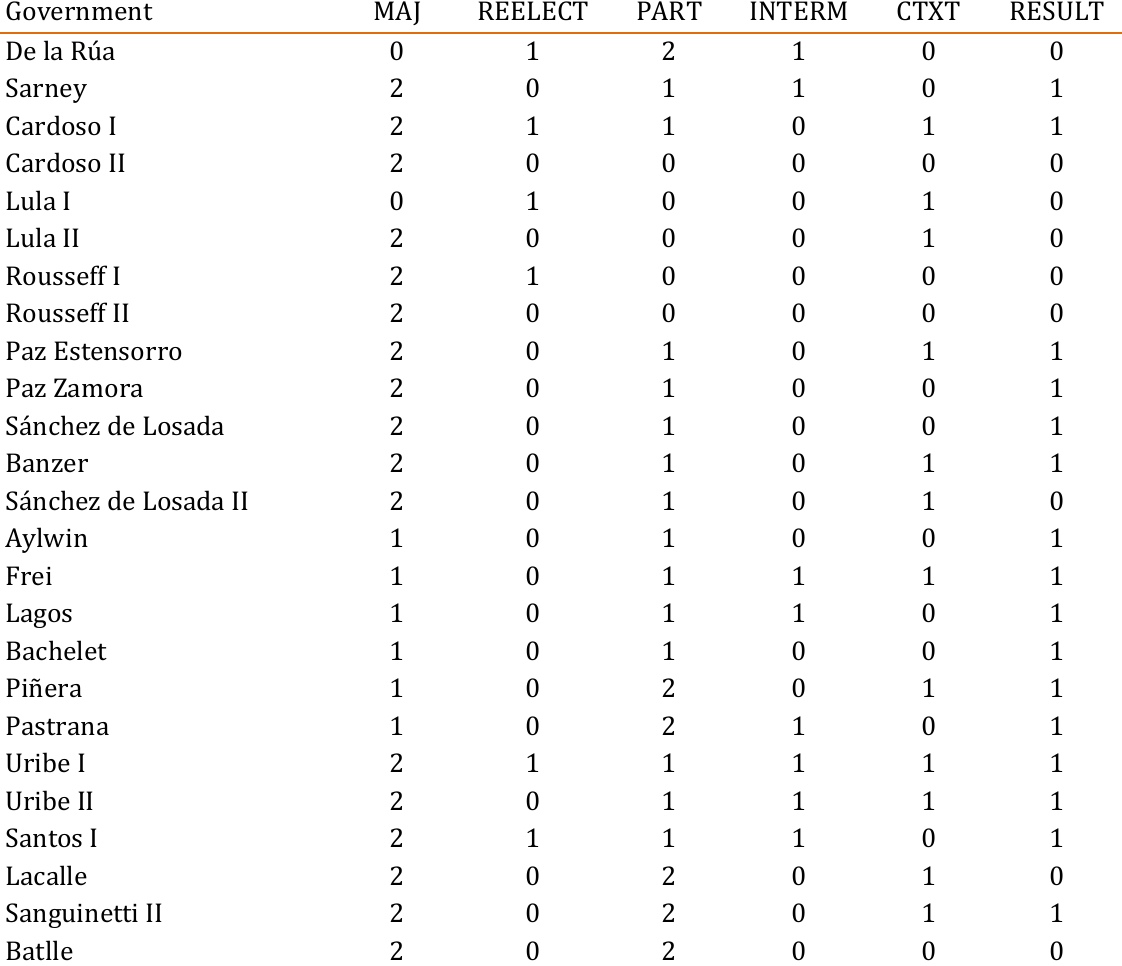
Table 05. Raw data matrix of coalition cabinets' survival/termination in Latin America Government MAJ REELECT PART INTERM CTXT RESULT De la Rúa 0 1 2 1 0 0 Sarney 2 0 1 1 0 1 Cardoso I 2 1 1 0 1 1 Cardoso II 2 0 0 0 0 0 Lula I 0 1 0 0 1 0 Lula II 2 0 0 0 1 0 Rousseff I 2 1 0 0 0 0 Rousseff II 2 0 Paz Estensorro 2 0 0 1 Paz Zamora 2 0 1 0 0 1 Sánchez de Losada 2 0 1 0 0 Banzer 2 0 Sánchez de Losada II 2 0 Aylwin 1 0 0 Frei 1 0 1 1 1 1 Lagos 1 0 Bachelet 1 0 0 0 1 Piñera 1 0 2 0 1 1 Pastrana 1 0 2 1 0 1 Uribe I Uribe II Santos I Lacalle Sanguinetti